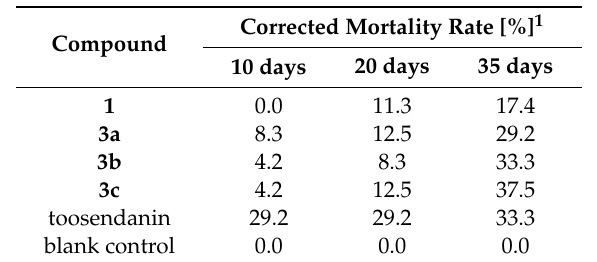
Table 1. Insecticidal activity of fraxinellone C-ring cyclopropyl analogues 3a – 3c against M. separata on leaves treated with a concentration of 1 mg / mL.